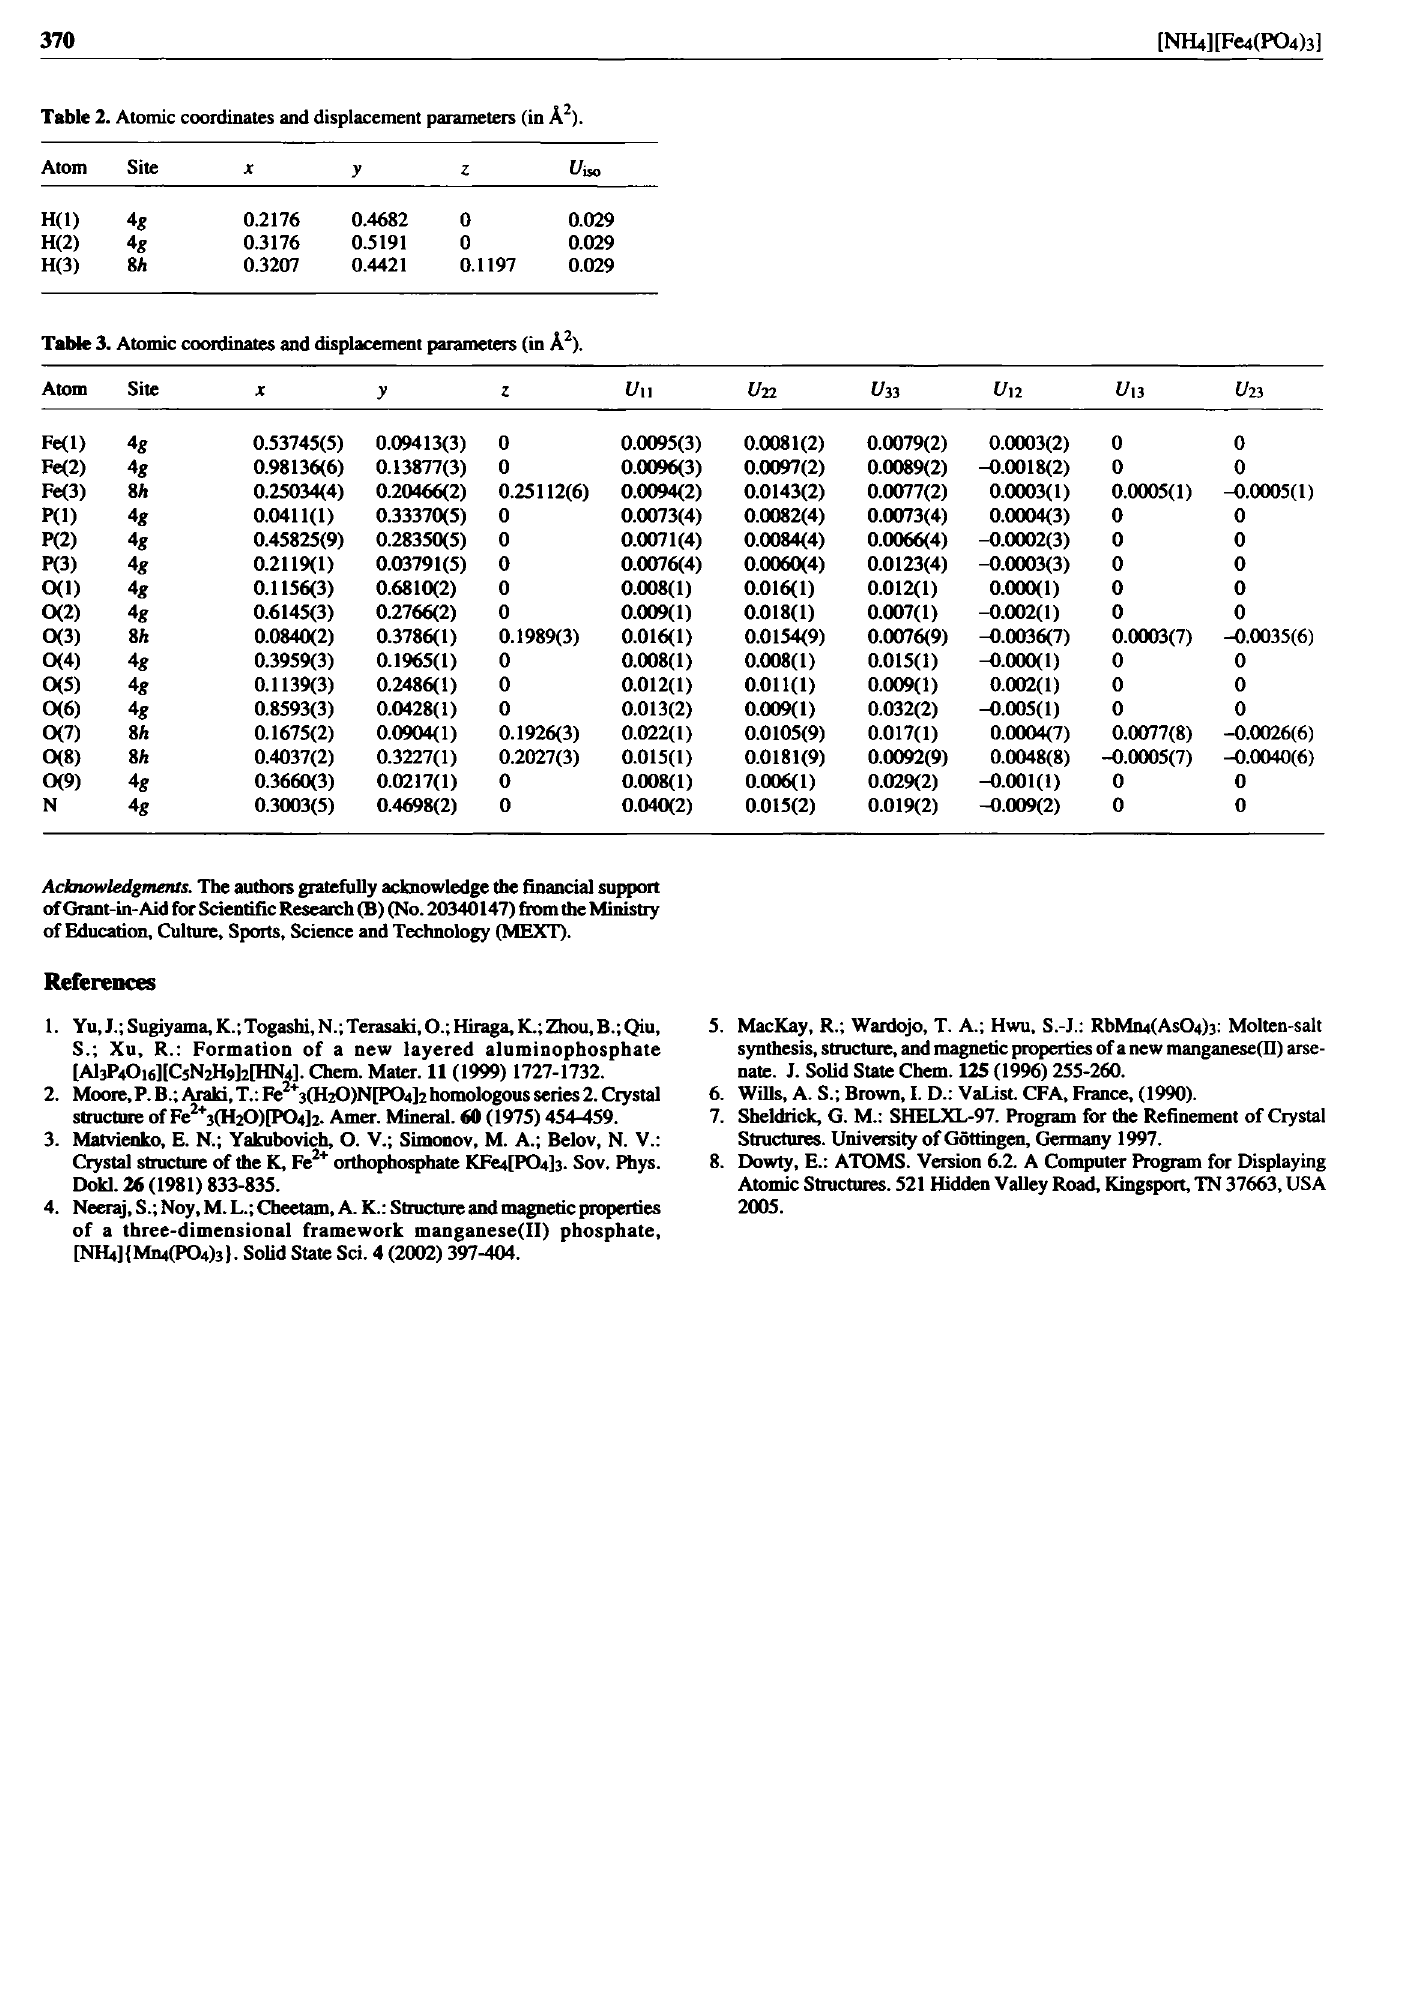
Table 2. Atomic coordinates and displacement parameters (in Â 2 ).